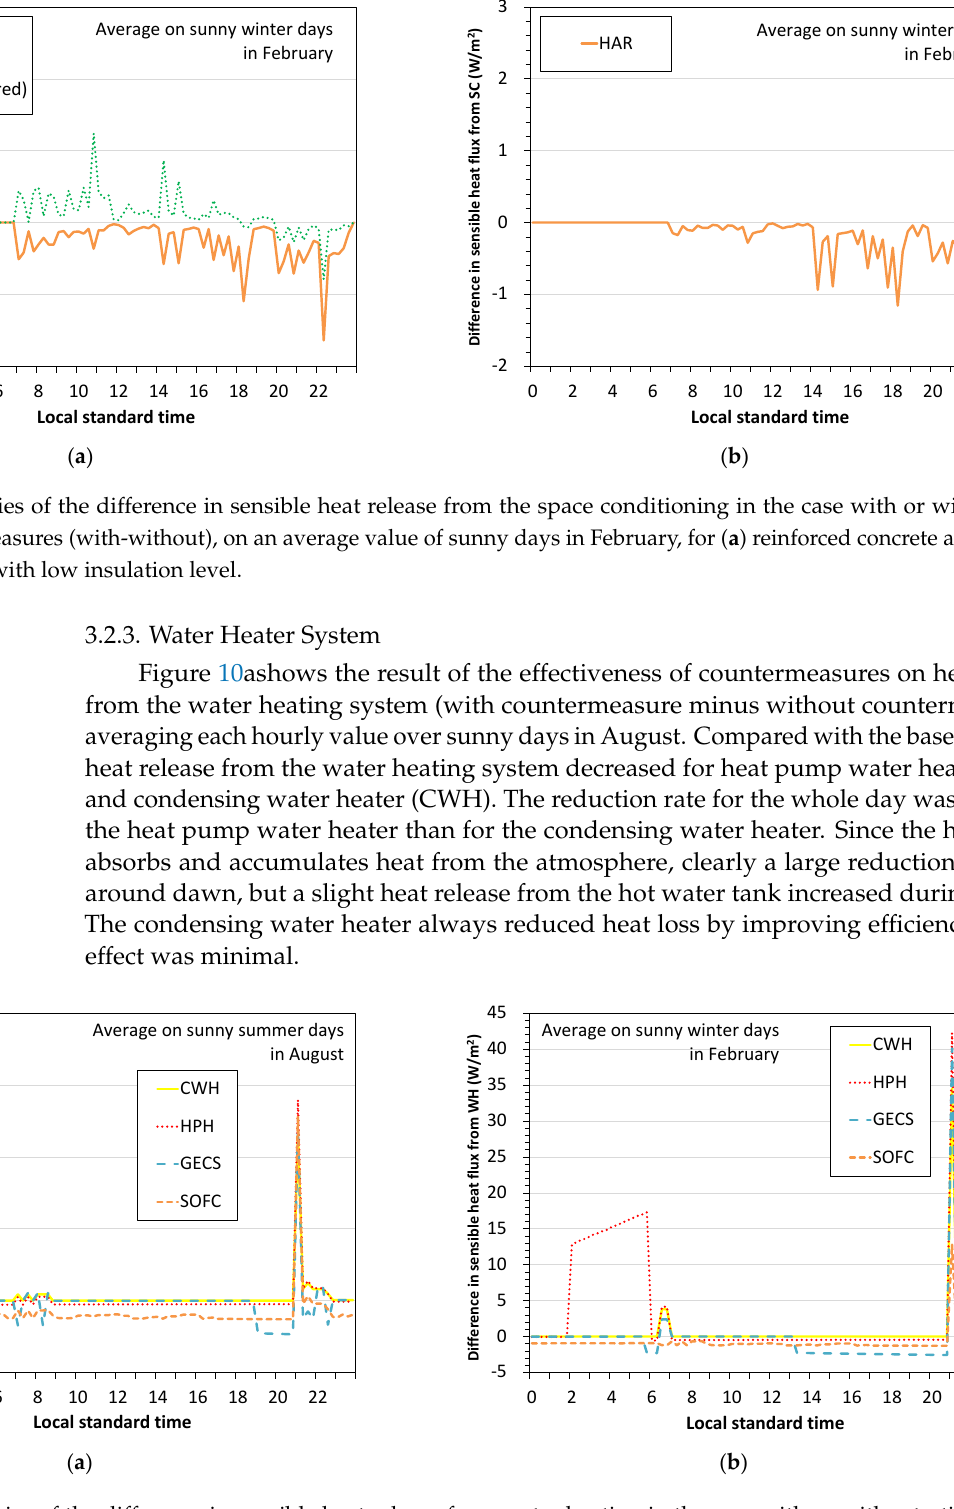
Figure 10. Time series of the difference in sensible heat release from water heating in the case with or without utilizing countermeasures (with-without), on an average value of sunny days, for ( a ) August and ( b ) February.